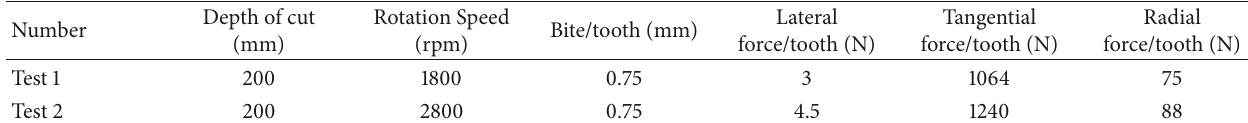
Table 3: Summarized cutting forces, based on experimental cutting tests.